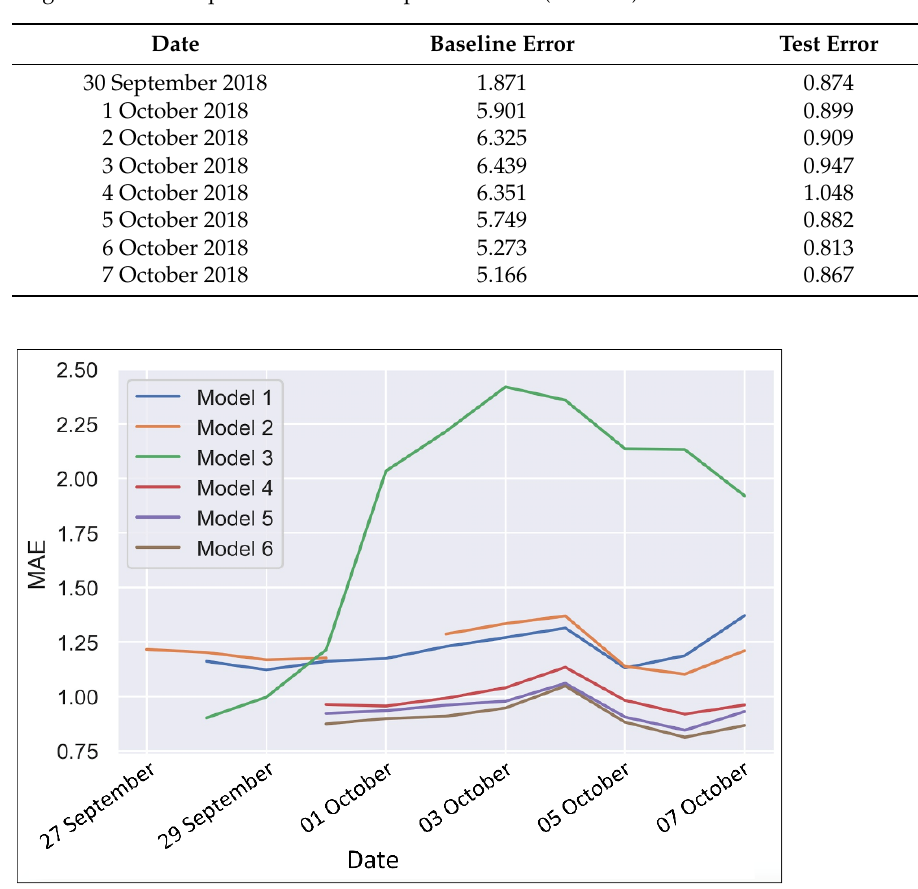
Table 7. Errors on the entire test set of a 35-parameter model by 1 h granularity and extended neigh-